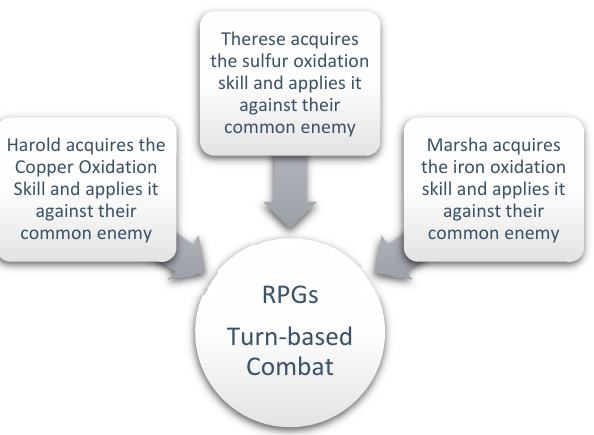
Figure 3. The RPG turn-based combat system provides a good example of using the playable character (PC) individual skills to defeat an enemy: Each player was rewarded with a different skill on the oxidations challenge. Those oxidation skills must be applied by the three players to successfully win the combat against their enemy.